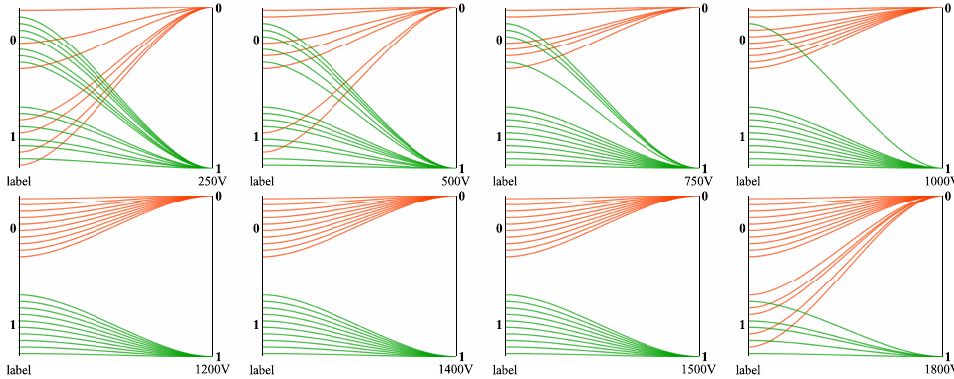
Figure 11. Crack detection results of eggs with different voltages by existing method [14]. Where, 0 in the figure represents cracked eggs, and 1 in the figure represents intact eggs; The green line indicates that the tested sample is classified as intact eggs, and the orange line indicates that the tested sample is classified as cracked eggs.